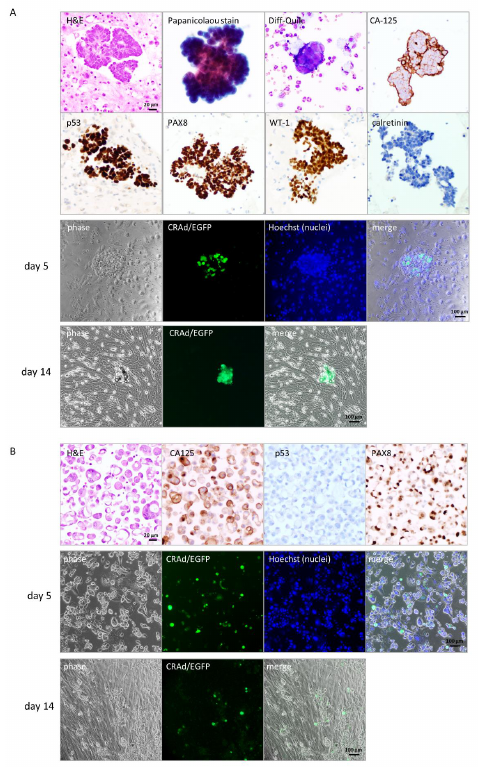
Figure 4. Ad5/MUC16-1040/TK-EGFP replicates in primary ovarian cancer cells. ( A ). Case 1 from malignant pleural effusion. Upper panel: Confirmation of high-grade serous ovarian cancer with expression of CA-125, PAX8, WT-1, and p53 (mutated pattern with abnormal strong diffuse expression), negative for calretinin; lower panel: Ad5/MUC16-1040/TK-EGFP replicates in primary ovarian cancer cells indicated by expression of EGFP signal, scale bar: 20 µ m, magnification: 400 × . ( B ). Case 2 from ascites. Upper panel: Confirmation of high-grade serous ovarian cancer with expression of CA-125 and PAX8, negative for p53 (null pattern); lower panel: predominant cancer cells with EGFP expression, indicating virus replication, scale bar: 100 µ m, magnification: 100 ×